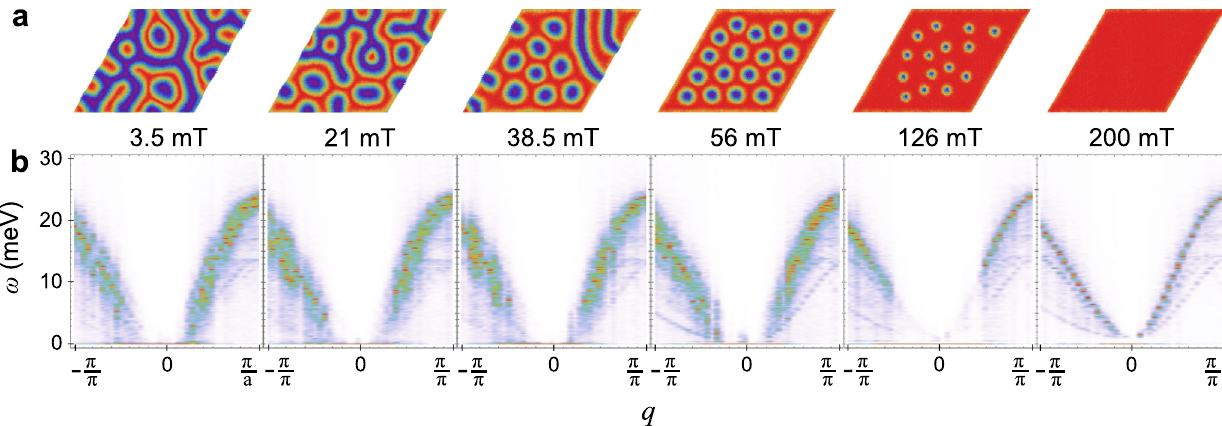
Fig. 4 Simulated spin texture and magnon spectra. a Representative spin textures and b magnon spectral functions, obtained from atomistic spin dynamics simulations of GaV 4 S 8 at T = 12 K and magnetic fi eld magnitudes, as indicated at the top of each panel.